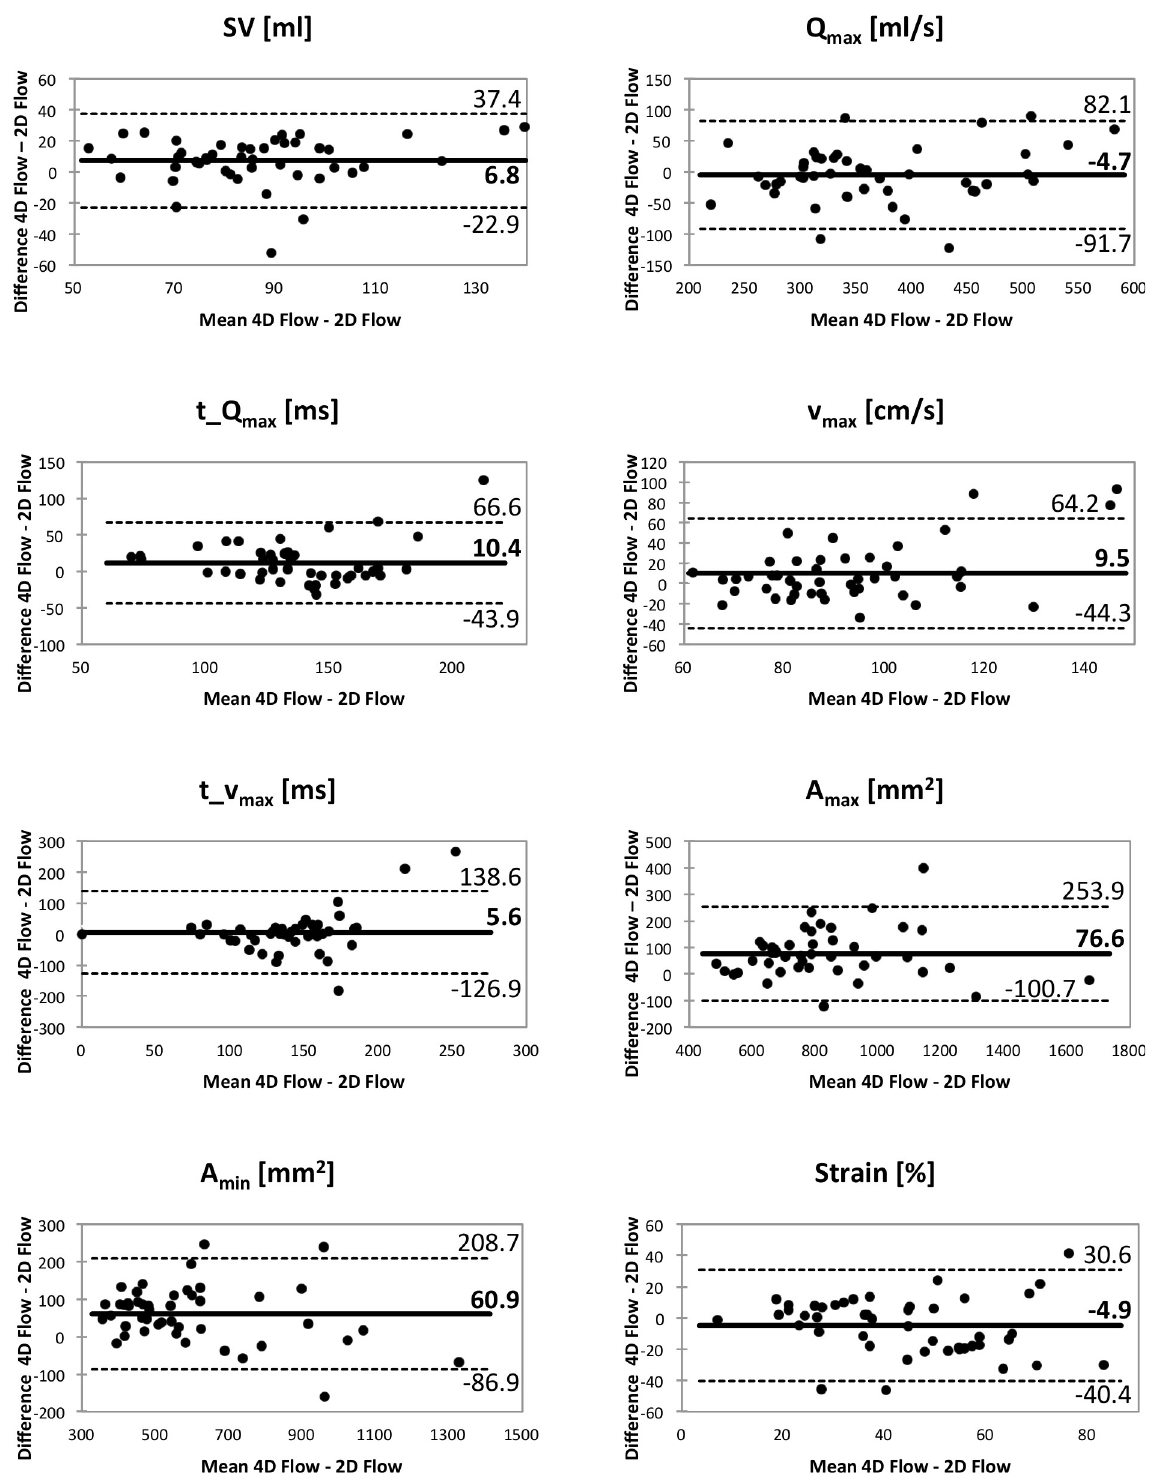
Fig 3. Bland-Altman plots for all evaluated hemodynamic and anatomical parameters for the comparison between 4D Flow and 2D Flow MRI. The solid line indicates mean bias between techniques, dashed lines indicate limits of agreement (mean bias ± 1.96 standard deviations).